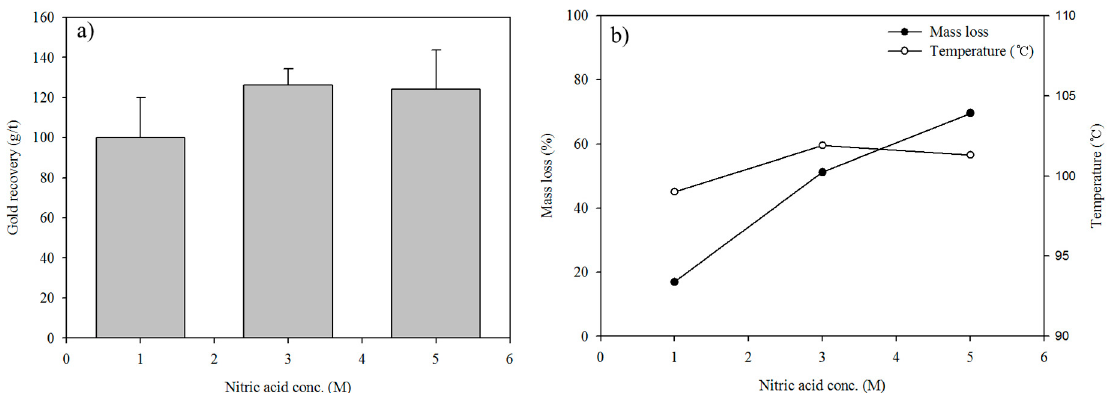
Figure 13. Effect of HNO 3 concentration on the ( a ) recovery of gold and ( b ) mass loss and reaction temperature from the refractory gold concentrate. The leaching conditions were a reaction time of 15 min and an HNO 3 concentration of 1.0, 3.0 and 5.0 M.